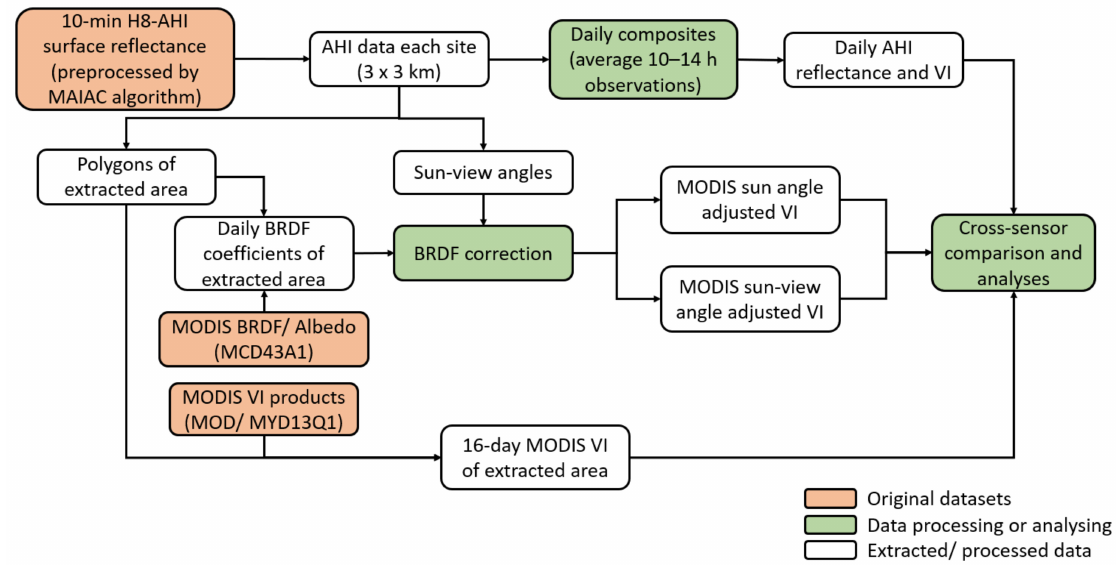
Figure 3. Workflow diagram of Advanced Himawari Imager (AHI) and Moderate Resolution Imaging Spectroradiometer (MODIS) data extraction, BRDF corrections, AHI daily compositing, and cross-sensor analyses.